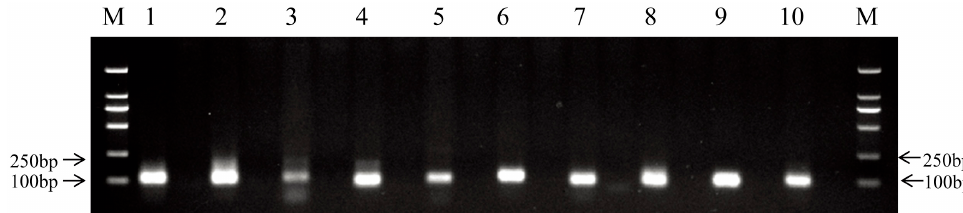
Figure 4. Validation of novel miRNAs by RT-PCR. M : DL2000 marker; Lanes 1 – 10 : novel miRNAs (miR-novel 3, miR-novel 7, miR-novel 13, miR-novel 20, miR-novel 24, miR-novel 28, miR-novel 33, miR-novel 34, miR-novel 41 and miR-novel 54). For each miRNA, the right lane is the negative control.